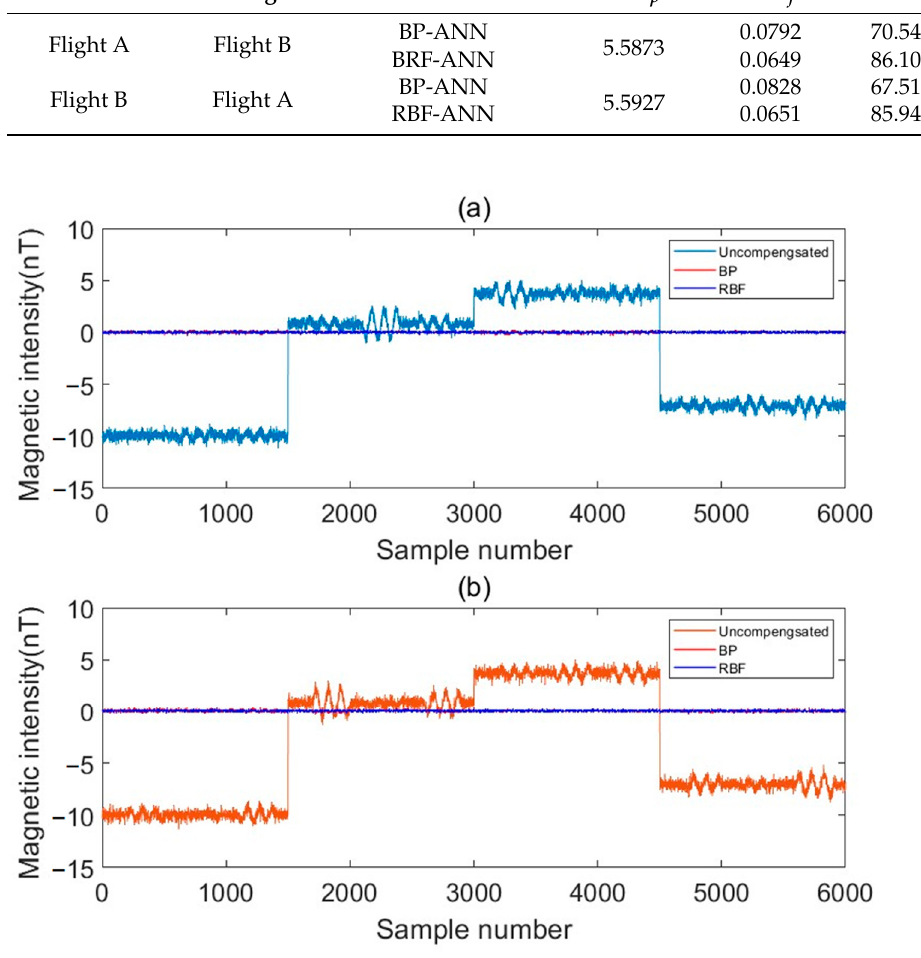
Figure 7. Simulation data compensation results: ( a ) test set flight A; and ( b ) test set flight